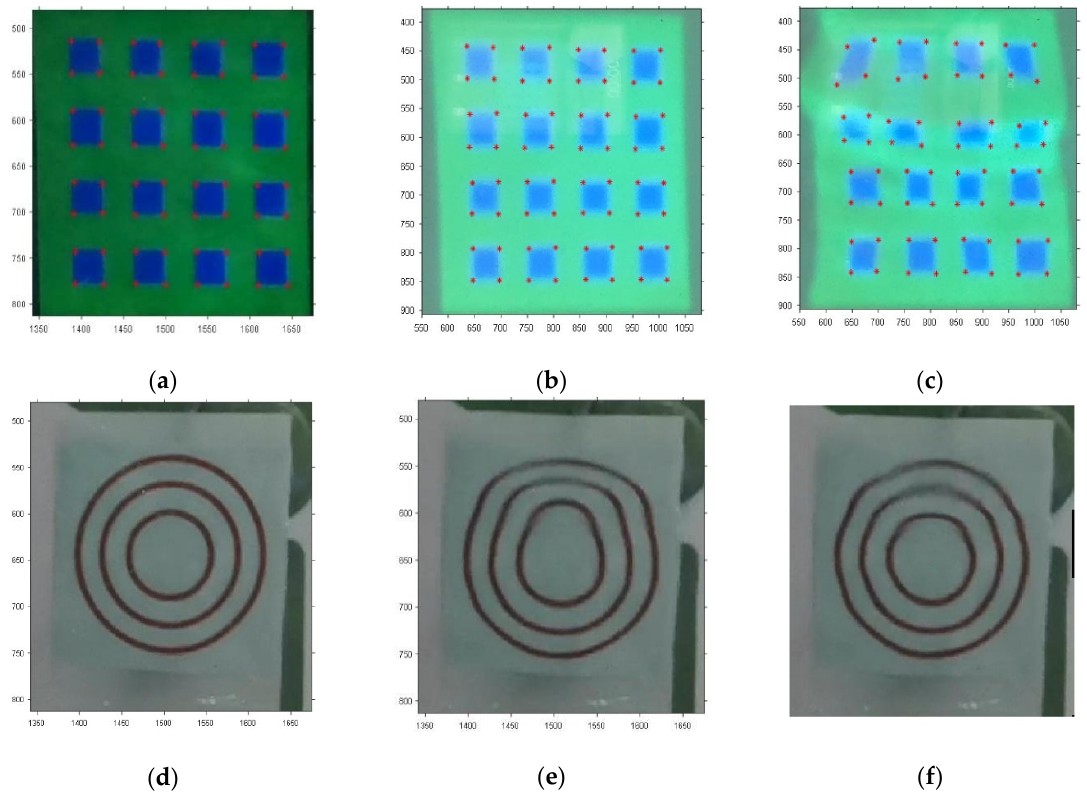
Figure 12. Processing image. ( a ) WAI sampling. ( b ) Reference structured light image as the WAI was flat. ( c ) Distorted structured light image. ( d ) Ground-truth image. ( e ) Distorted image. ( f ) Recovered image using our method.